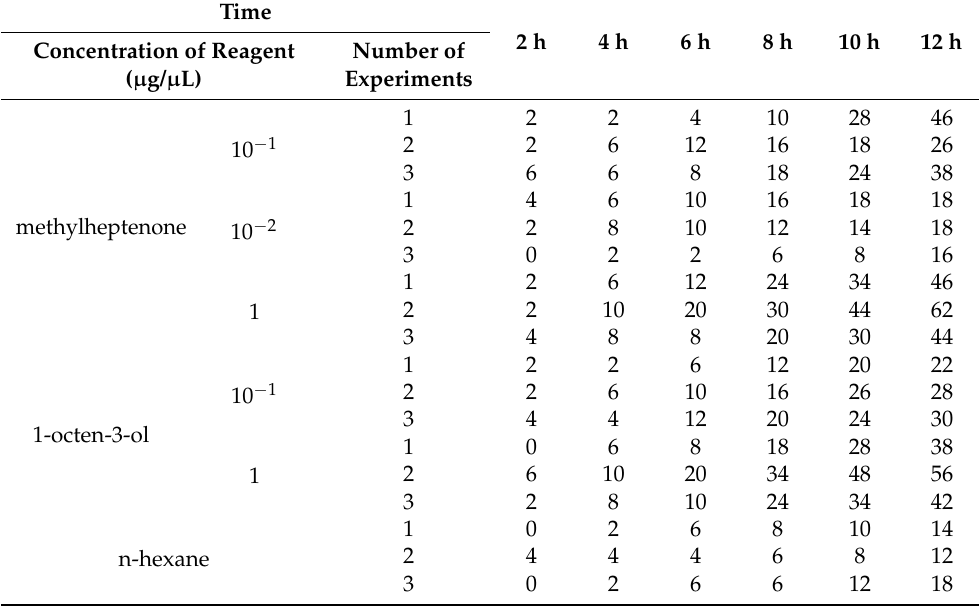
Table 7. Statistical table of the trapping for male W. magnifica with different concentrations of methylheptenone and